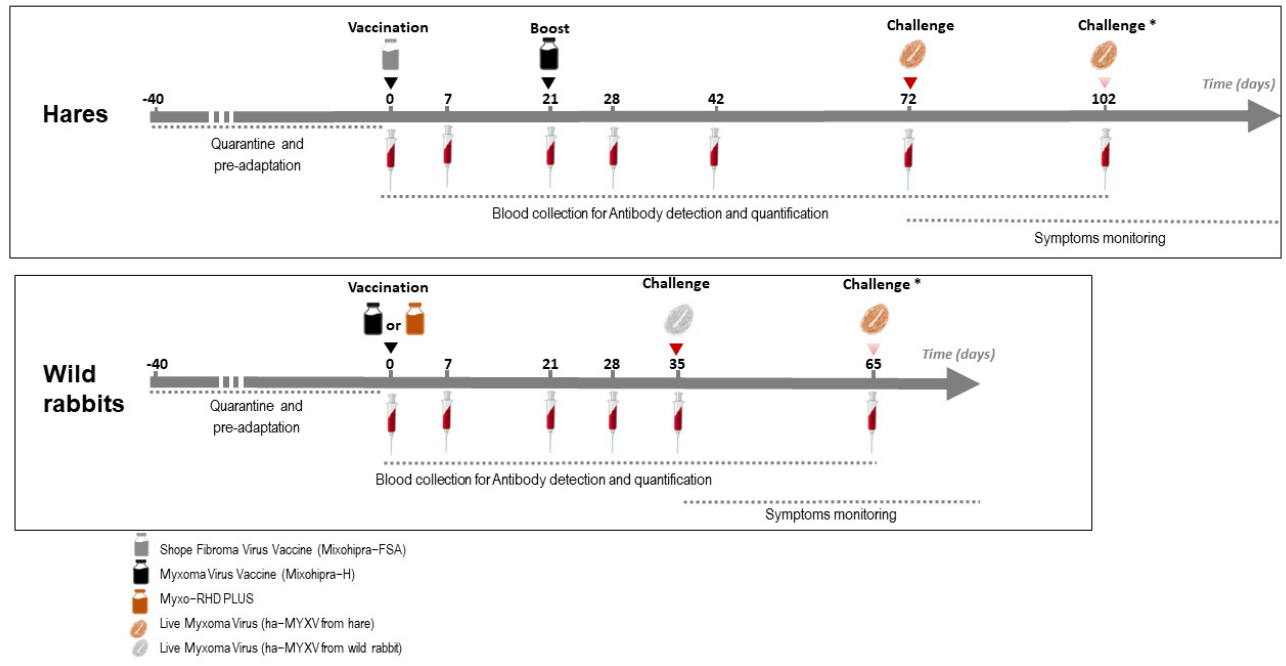
Figure 1. Schematic representation of the vaccination and sampling schedule performed on hares and rabbits (Studies 1 and 2). * The second challenge was only carried out on part of the animals (see Section 2.8).